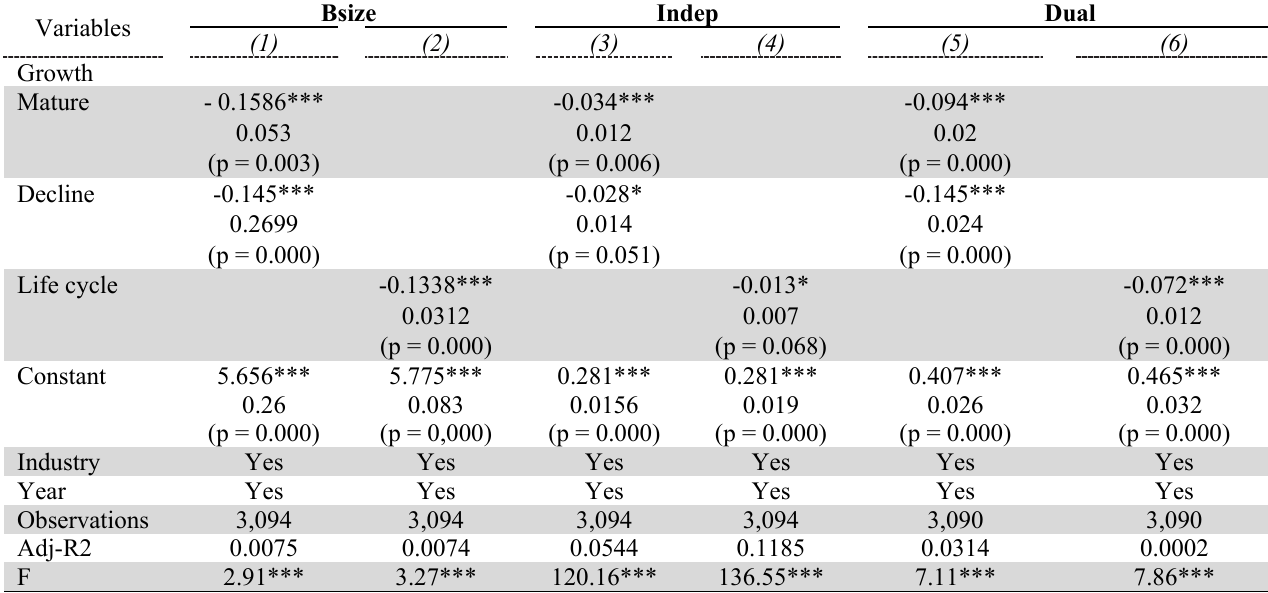
The impact of the firm’s life-cycle on board